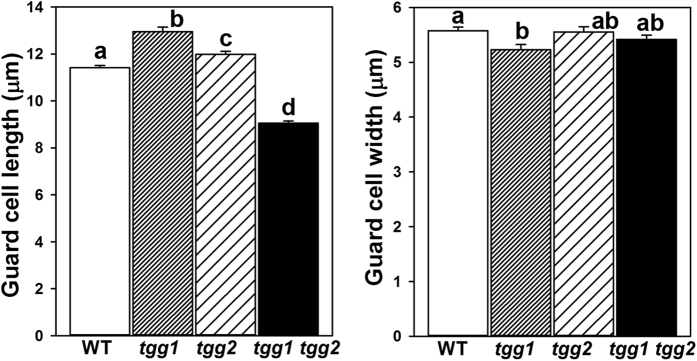
Measures of stomatal size in WT, tgg1, tgg2 single mutants, and tgg1 tgg2 double mutant.Average guard cell length and average guard cell width (stomatal aperture) were used as measures of stomatal size. Different letters above the bars indicate significant differences between WT, tgg1, tgg2 single mutants and tgg1 tgg2 double mutant (Kruskal-Wallis test, P < 0.05), followed by pairwise Wilcoxon Mann-Whitney tests and Bonferroni correction, P < 0.00417). Error bars represent the means ± SE (n = 100).